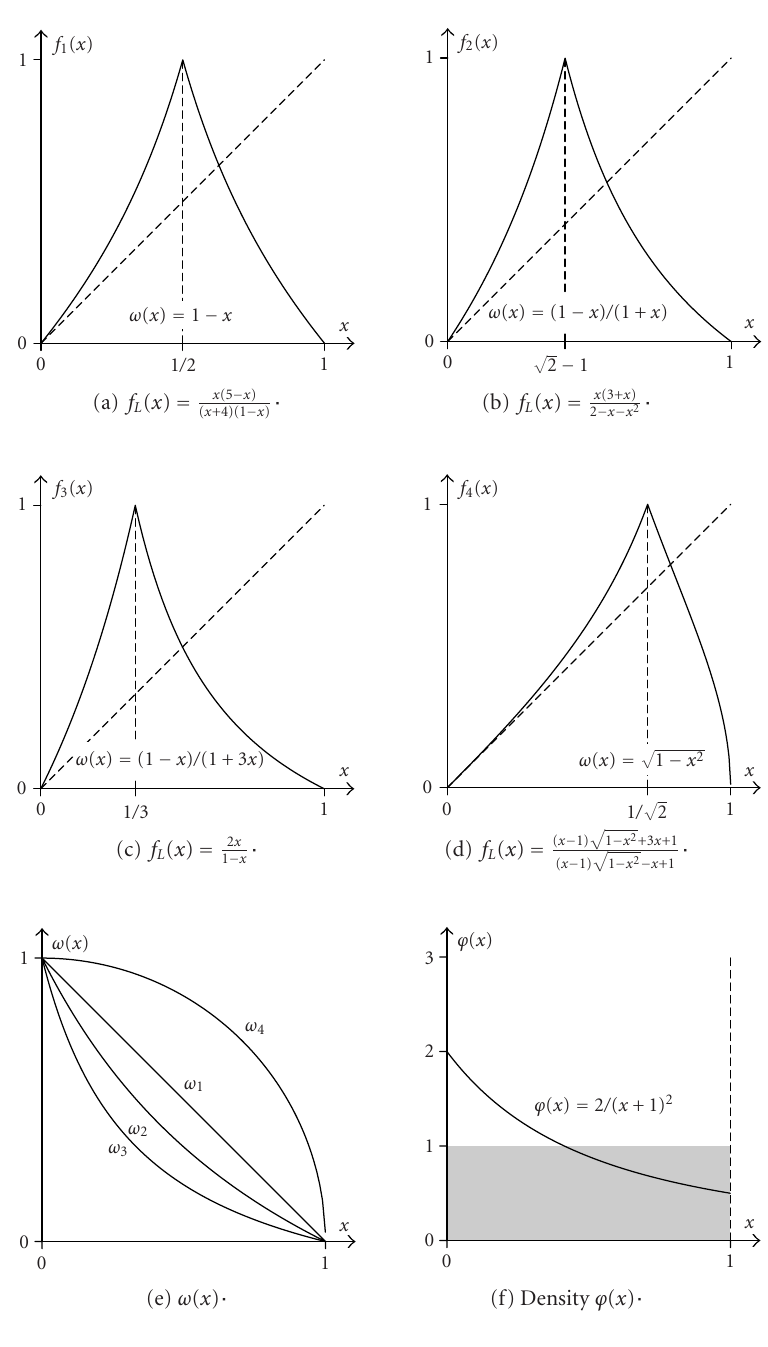
Figure 1.1. f L ( x ) = (( x − 1) ω ( x )+3 x +1) / (( x +3) ω ( x ) − x +1), x ∈ [0, ˆ x )